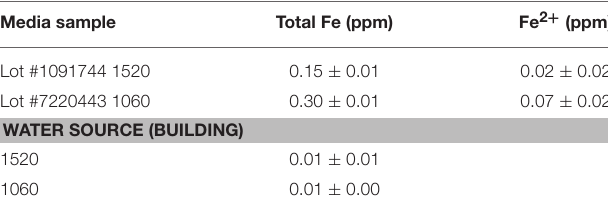
TABLE 3 | Elemental analysis of the two media lots and water